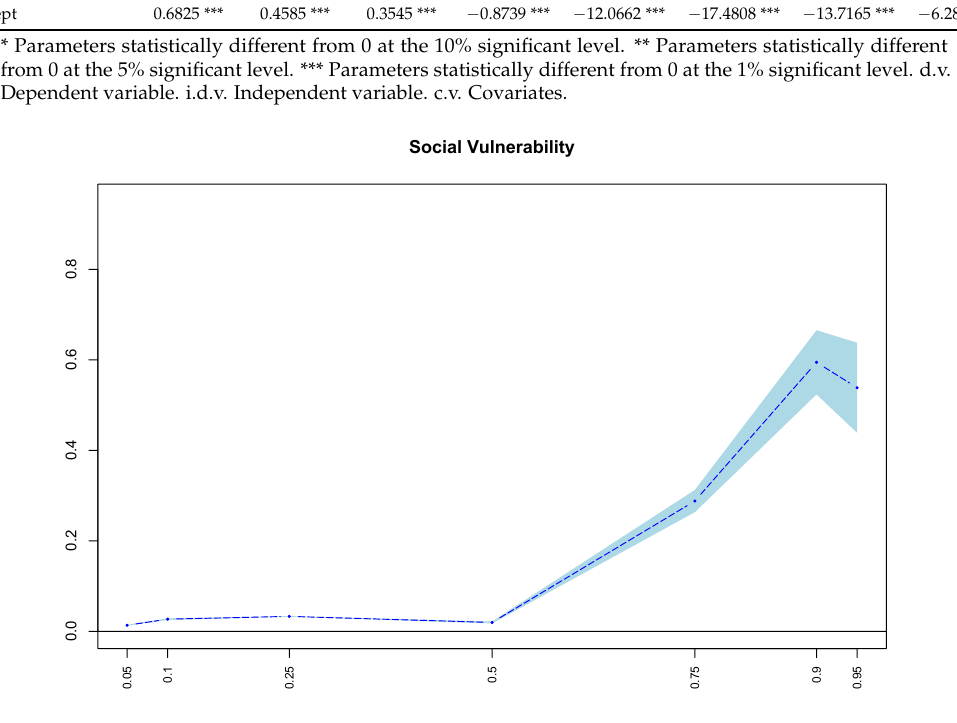
Figure 1. Coefficients of social vulnerability in full samples. Note: The horizontal axis represents quantiles of cognitive impairment, while the vertical axis represents coefficients of the social vulnerability variable. Bootstrapped standard error bars using 100 repetitions are reported. with blue